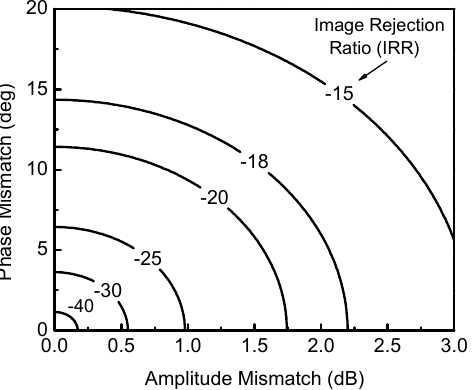
Figure 2. Theoretical image rejection ratio (IRR) with respect to the I/Q amplitude and phase mis ‐ matches.